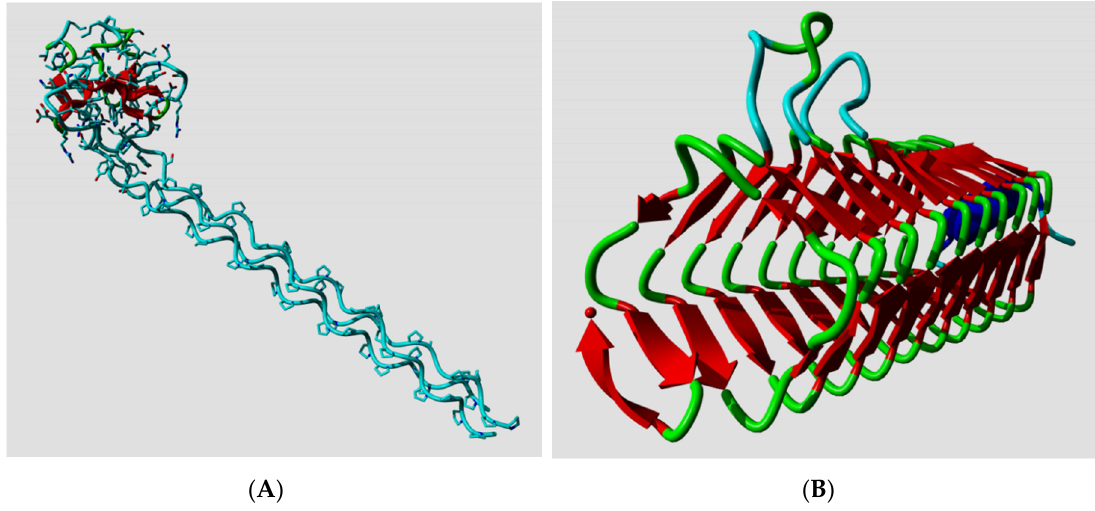
Figure 5. Structures with extreme secondary structures. ( A ) 1nay [36] is the protein with the highest “normality”, defined as the highest average P(aa i ,ss j )+P(aa i ,aan i ,ss j ,ssn j ). This protein has a long stalk with a type of helix that DSSP recognizes as loop. This stalk is rich in prolines and P(Pro,Loop) is very high so that the normality of this protein is high. ( B ) 3du1 [37] is the protein with the lowest “normality”. The repeats in this protein are kept together by (cooperative) interactions along the tube. The strands (red) are accidentally rich in residues for which P(aa,strand) is low while the (green) hydrogen bonded turns and (blueish) loops contain residues for which this parameter is high (and thus P(aa,turn) is low).